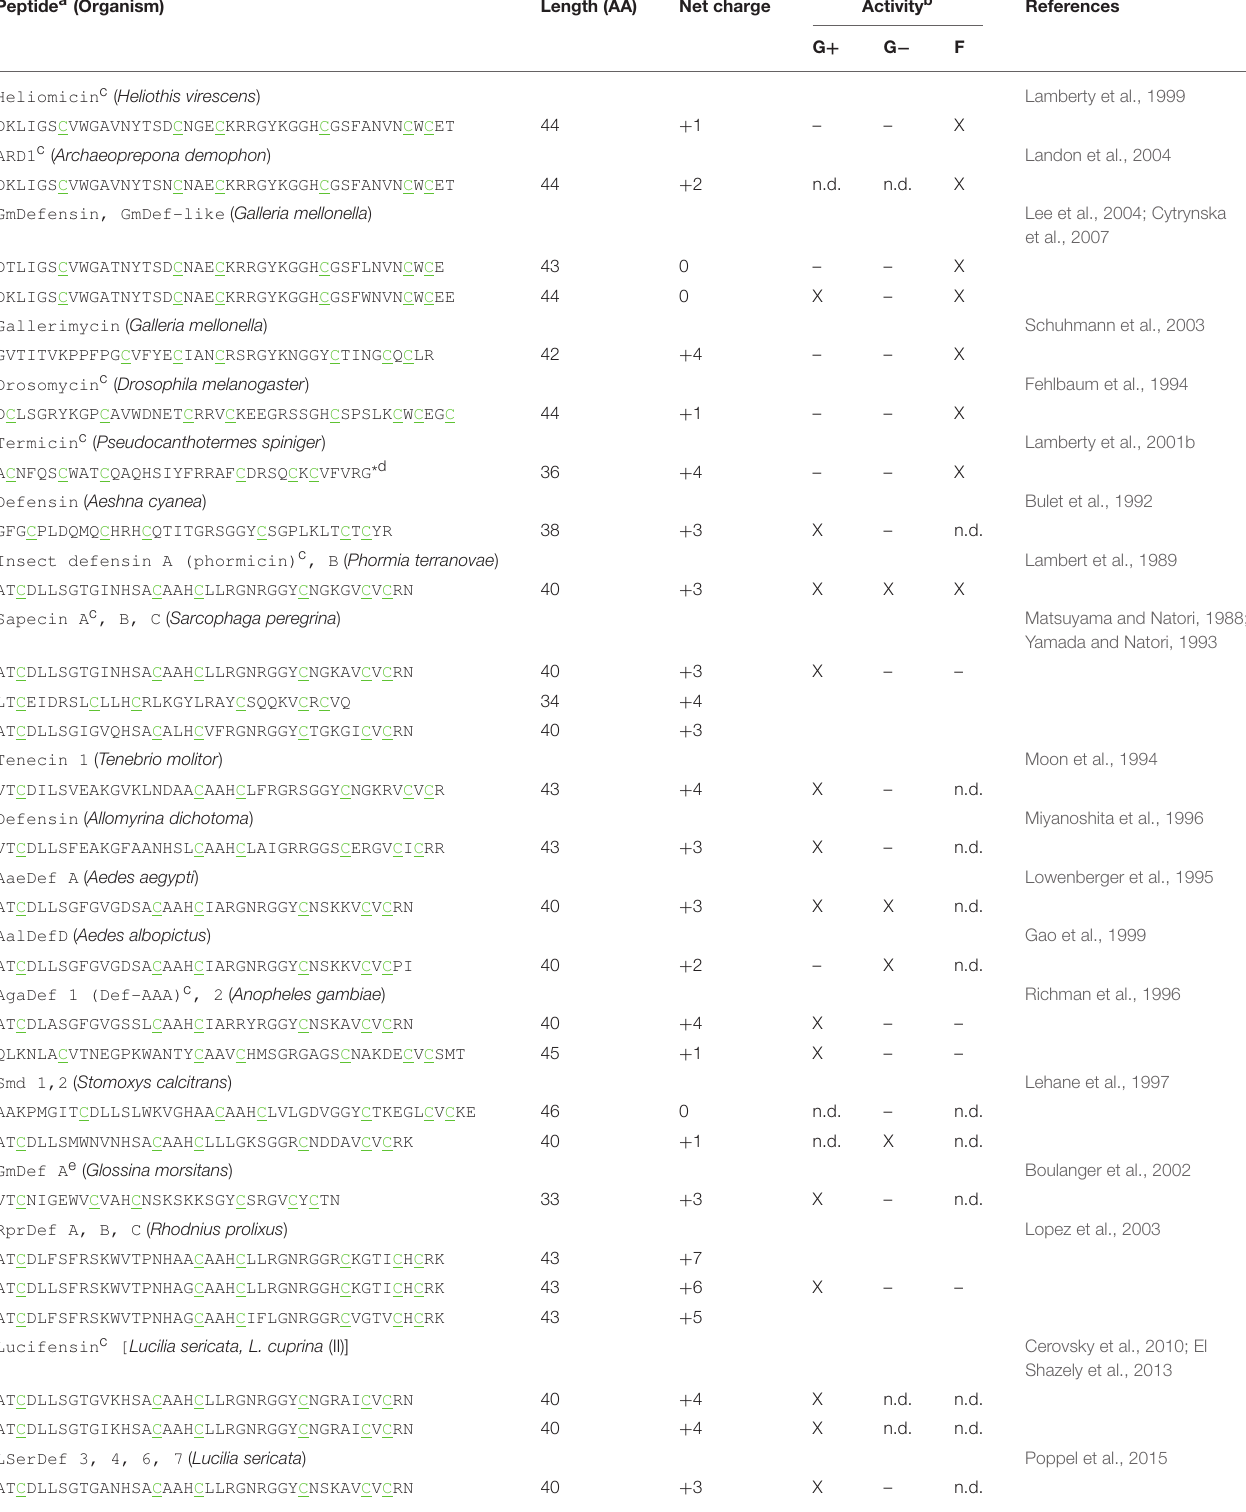
TABLE 1 | Naturally occurring insect defensin peptides with reported antimicrobial activity. Peptide a